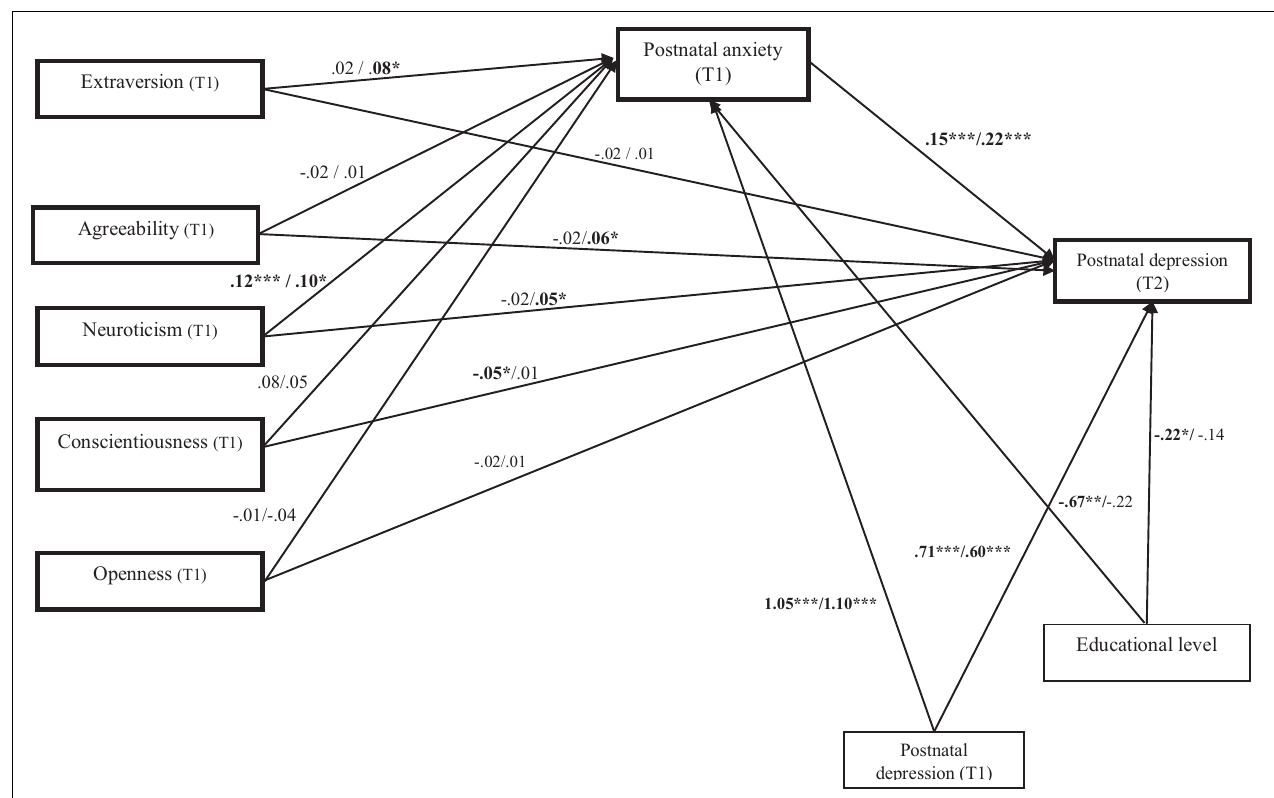
FIGURE 2 | Unstandardized path estimates of the multi-group mediation model. From left to right, the unstandirdized coefficients for the natural birth group were presented firth and then for the cesarean procedure type of birth group. Postnatal depression (T1) = postnatal depression after 3 or 4 days, Postnatal depression (T2) = postnatal depression after 2 weeks. Postnatal anxiety (T1) = postnatal anxiety after 3 or 4 days. ∗ p < 0.05; ∗∗ p < 0.01; ∗∗∗ p <